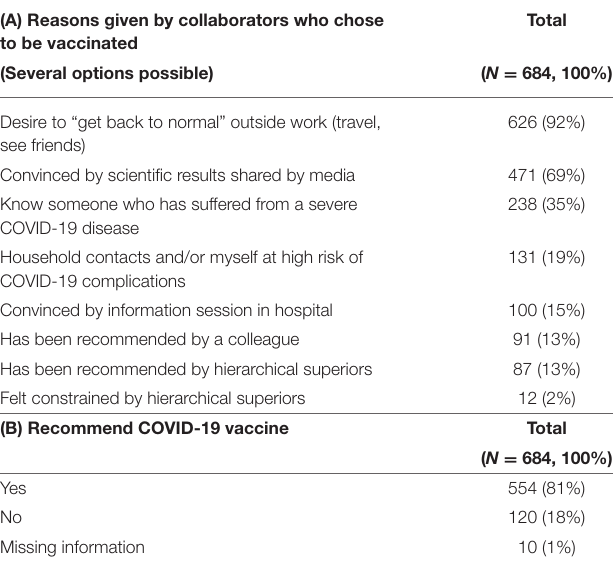
TABLE 4 | Vaccinated collaborators: attitude towards COVID-19 vaccination. TABLE 5 | Non-vaccinated collaborators: attitude towards COVID-19